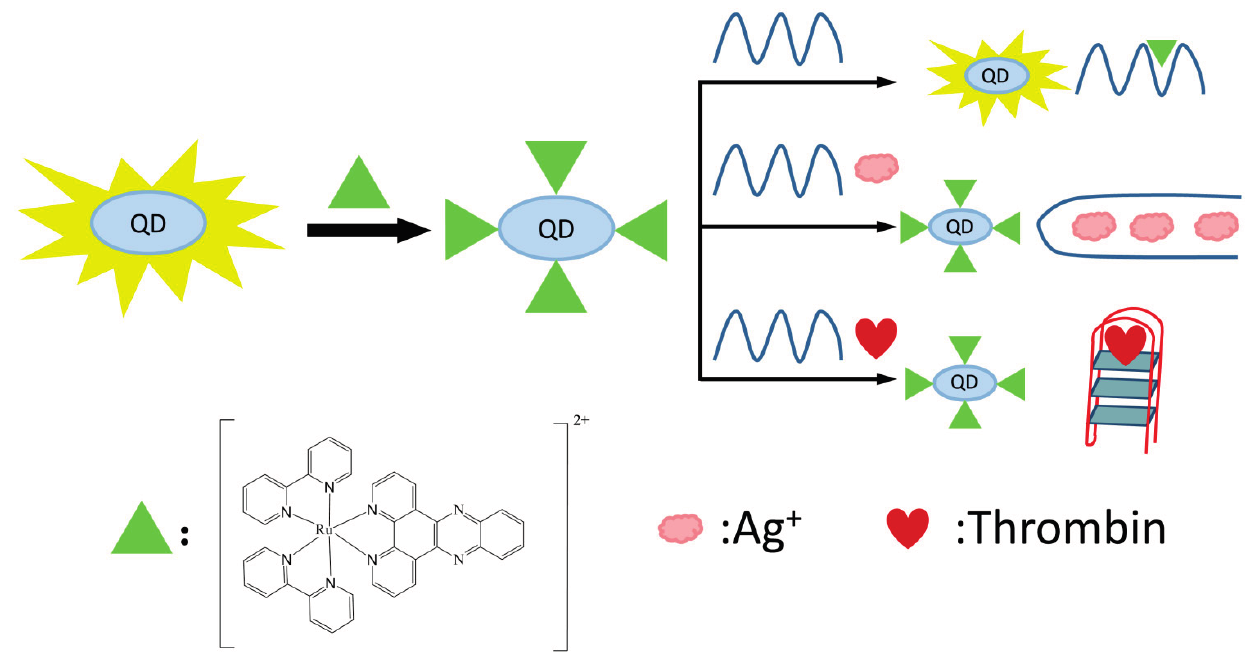
Figure 30. Bioanalysis using Ru[(bpy) permission from ref. [261], copyright (2013)